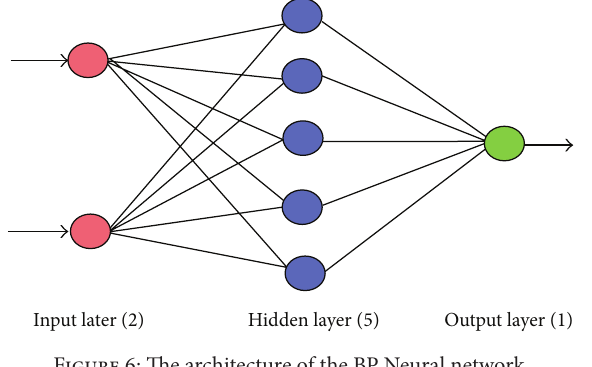
Figure 6: The architecture of the BP Neural network.